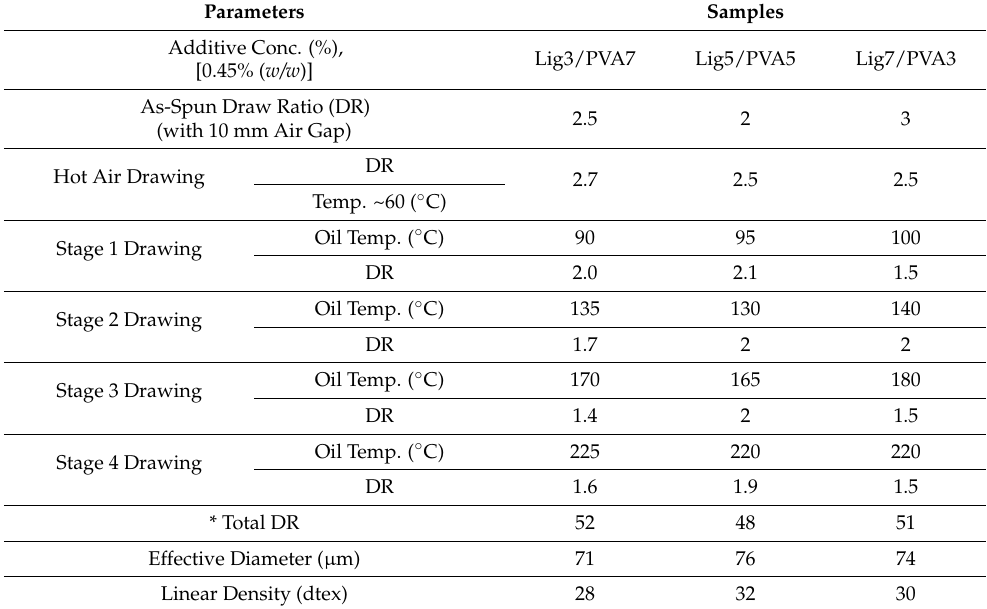
Table 1. Drawing Parameters of Gel-Spun Lignin/PVA Fibers at 0. 45%